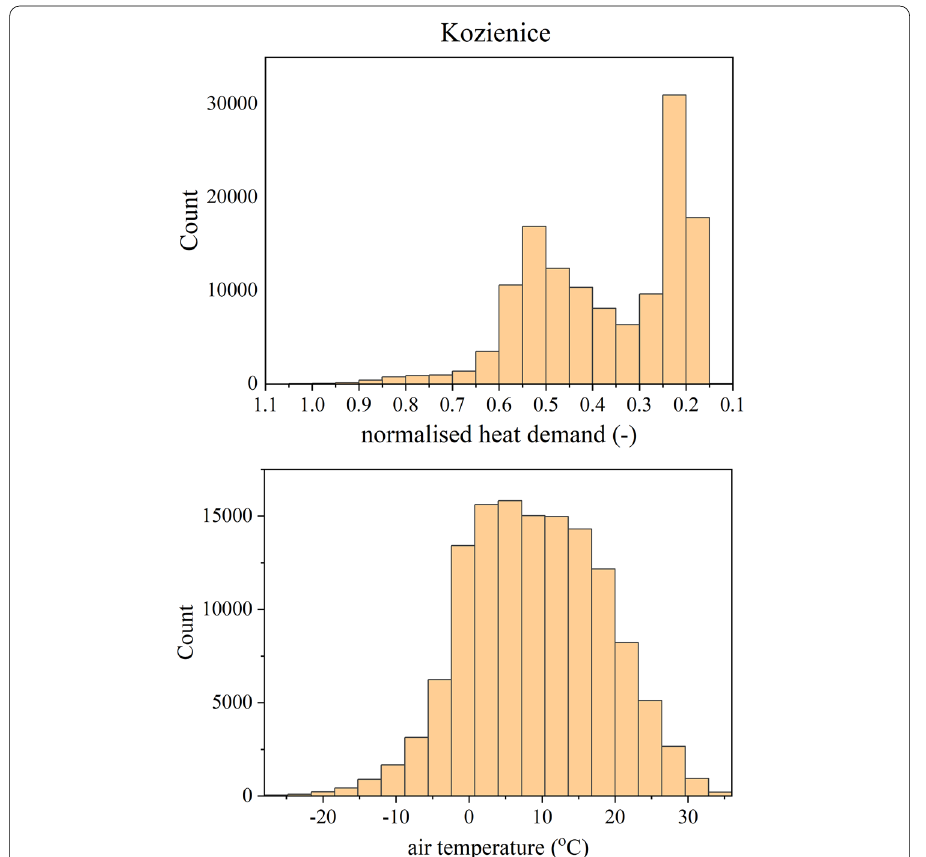
Fig. 4 Temperature (lower) and heat demand (upper) histograms. The bimodal histogram of heat demand results from there being two clearly distinct seasons: summer (with SHW preparation) and winter (SHW and space